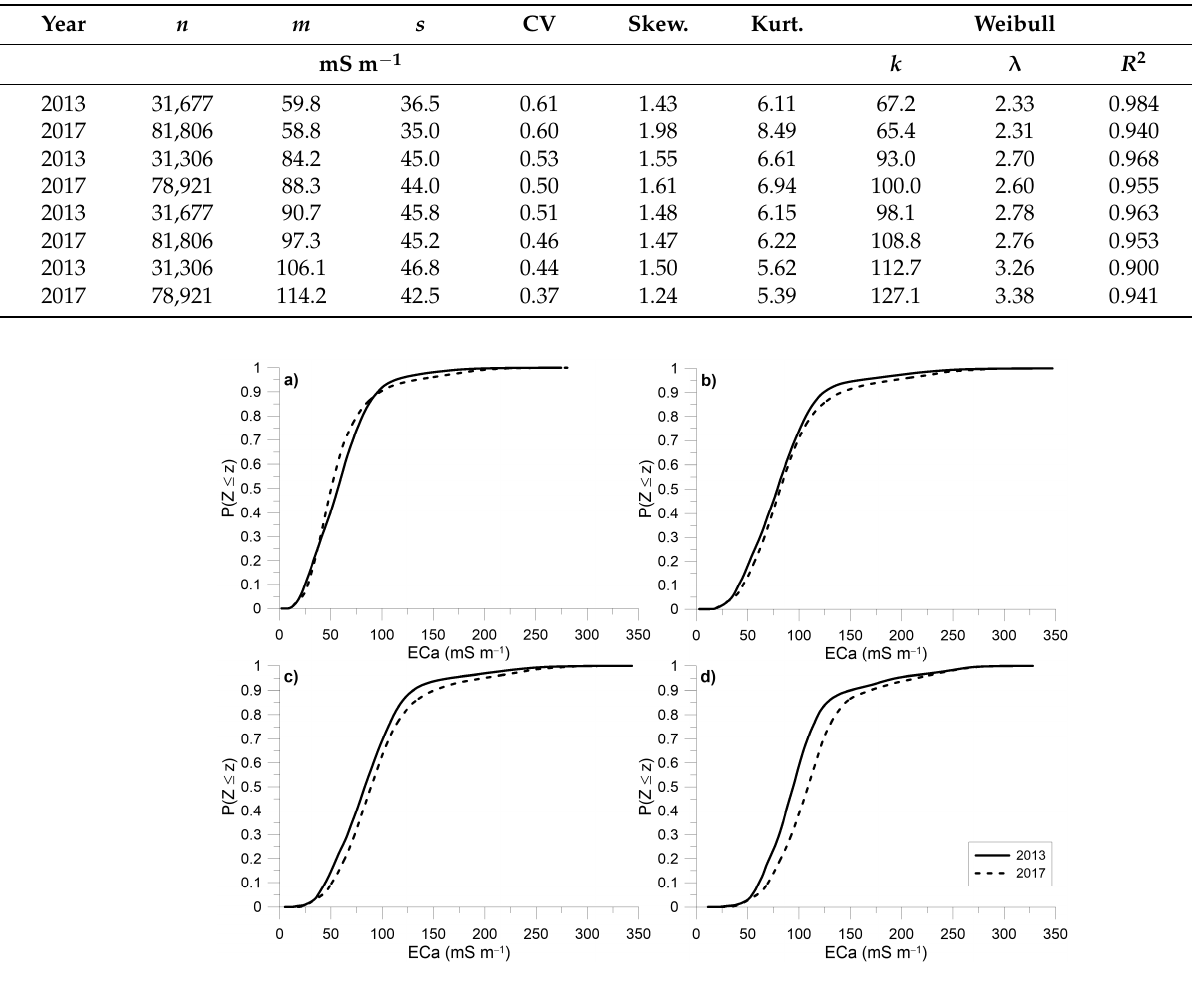
Figure 2. Cumulative distribution functions of interpolated ECa measured in November 2013